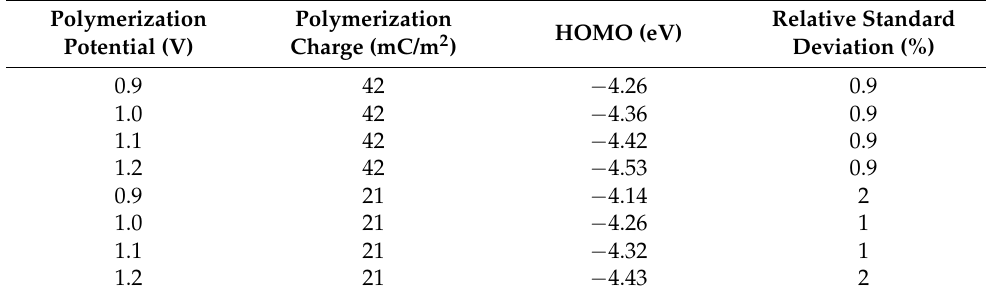
Table 3. HOMO energy levels of PPy films synthesized at different potentials and under control of electric charge (n = 3). These values were calculated according to Equation